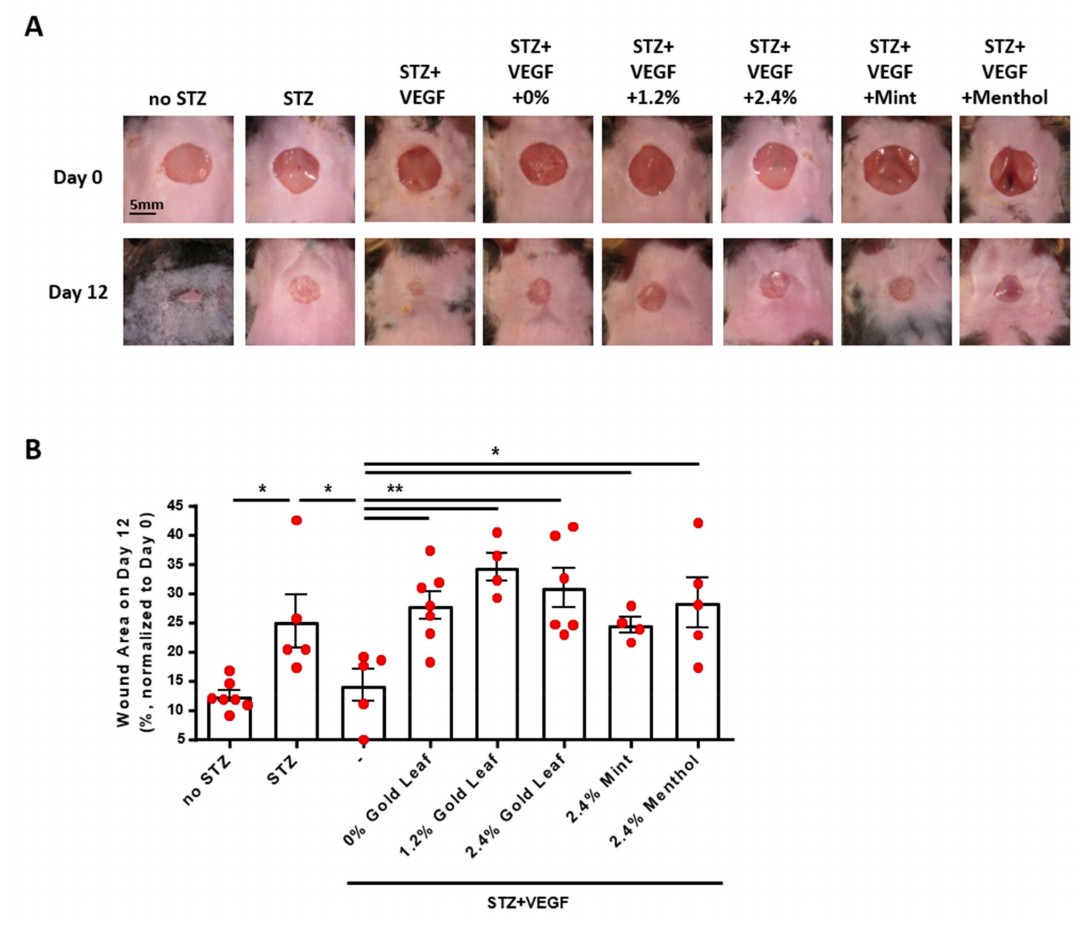
Figure 5. Nicotine-containing and flavored e-cigarettes induce impaired diabetic wound healing in vivo. Wild type male C57BL/6 mice (10–12 weeks old) were treated with two injections (i.p.) of streptozocin (STZ, 100 mg/kg). Seven days after diabetic induction, a 6-mm skin wound was made by a biopsy punch, and the wound was imaged and labeled as Day 0. The wound area was treated with VEGF (200 ng) in the presence or absence of e-CSE (no dilution from 100% stock of original preparation, 5 µ L) every other day till Day 12. Scale: 5 mm. ( A ) Representative images of wound area on Day 0 and Day 12 in diabetic mice treated with e-CSEs prepared from e-cigarettes containing different levels of nicotine (Gold leaf [Blu] with 0%, 1.2%, and 2.4% nicotine levels) and different flavors (Mint and Menthol with 2.4% nicotine from Blu). ( B ) Grouped data for sizes of wound areas on Day 12 as a percentage of wound area on Day 0, indicating delayed diabetic wound healing in mice treated with e-CSEs prepared from e-cigarettes containing different levels of nicotine and different flavors ( n = 4–7). * p < 0.05, ** p < 0.01 by One-Way ANOVA with Newman–Keuls post hoc